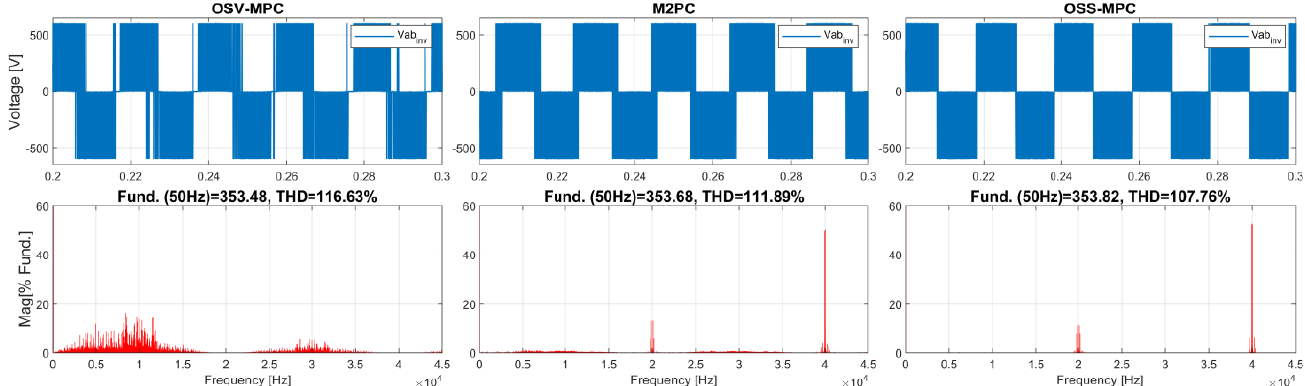
Figure 15. Output VSI line voltage and spectrum for each FCS-MPC technique for 𝑃 ∗ = 4 kW, 𝑄 ∗ = 4 kVAr.